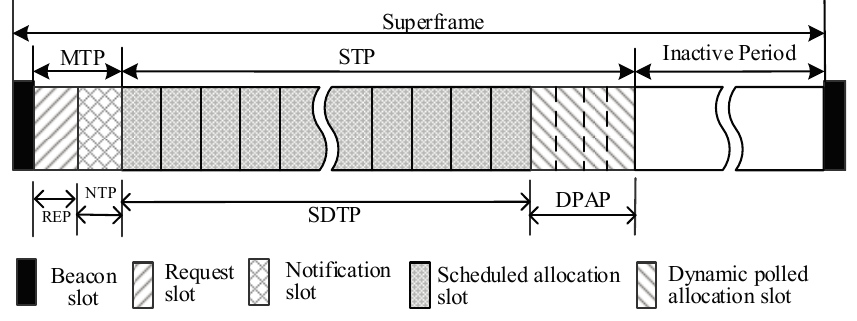
Figure 5. Modified superframe layout of lifetime extended directional approach medium access